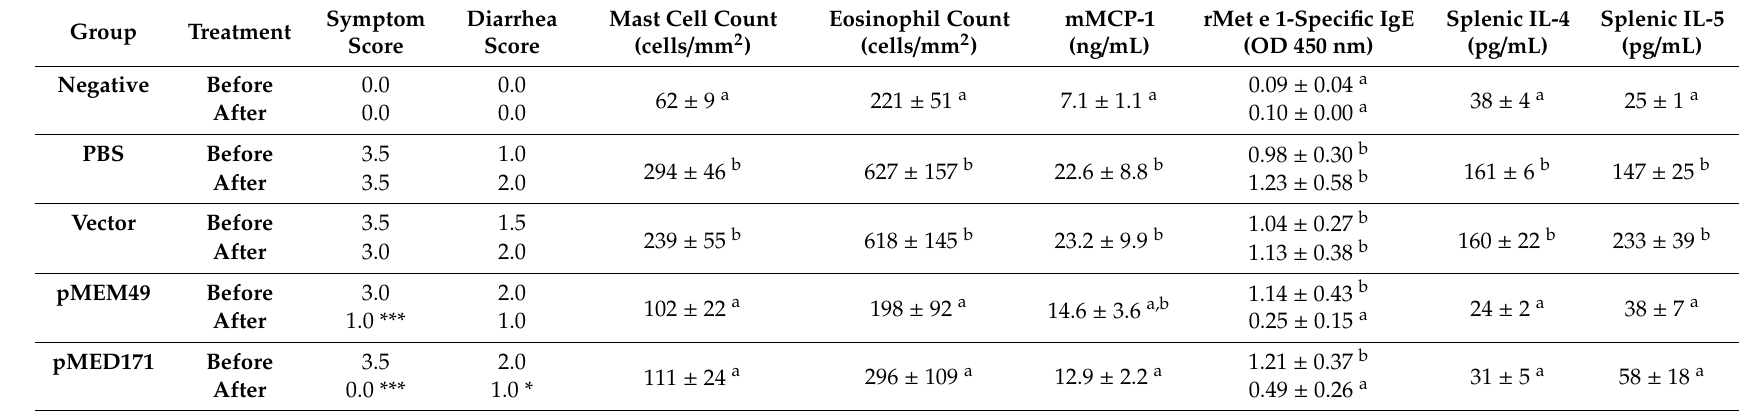
Table 1. Systemic Th2 inflammatory responses in control and treatment groups. Symptom and diarrhea scores are presented as median while other data are shown as mean ± SD. Statistical di ff erences of the symptom and diarrhea scores before and after treatment within each experimental group were assessed by Mann–Whitney U groups denoted by the same alphabet are not significantly di ff erent, while those denoted by di ff erent alphabets are statistically di ff erent ( p <